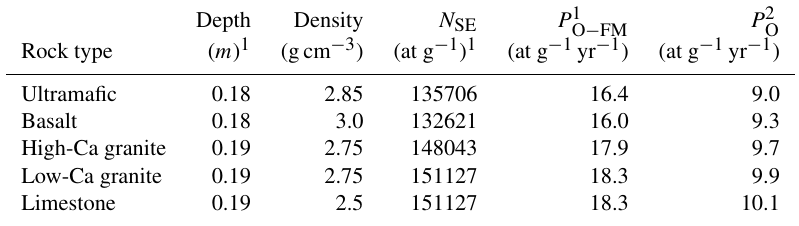
Table 4. Predicted modern in situ 14 C production rates at SLHL for neutron spallation from O derived from secular equilibrium concen- trations ( N SE ) at ca. 20cm depth for different rock types (Fabryka-Martin, 1988) compared to our software framework. Note that these estimates are not normalized relative to P Qcal for straightforward comparison to Fabryka-Martin’s (1988) predictions.